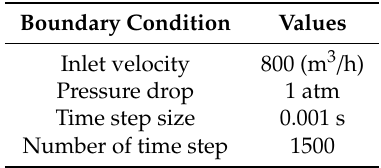
Figure 3. Computational domain of cyclone separators. Table 1. Boundary condition for computational fluid dynamics